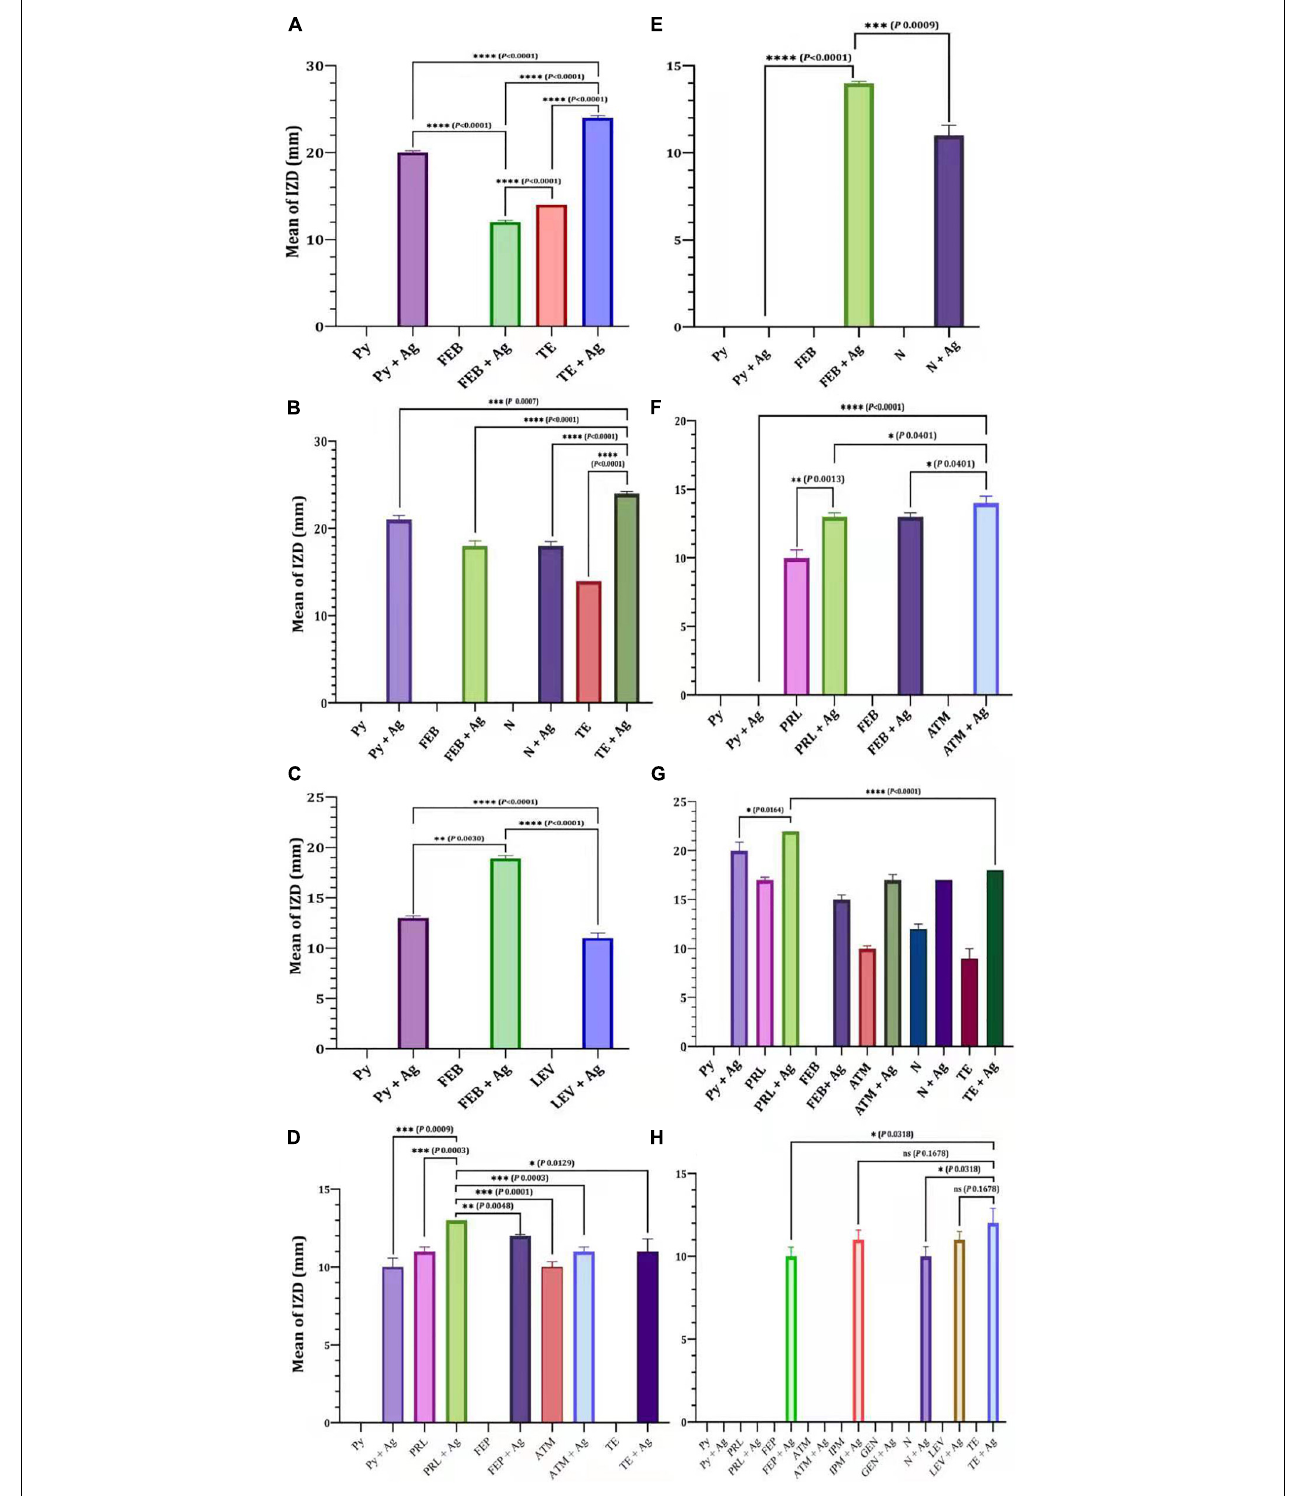
FIGURE 4 | Efficacy of antibiotics alone or in combination with Ag-NPs against selected MDR P. aeruginosa isolates. P. aeruginosa P 1 (A) , P. aeruginosa P 8 (B) , P. aeruginosa P 12 (C) , P. aeruginosa P 18 (D) , P. aeruginosa P 2 (E) , P. aeruginosa P 10 (F) , P. aeruginosa P 14 (G) , P. aeruginosa P 16 (H) . IPM, imipenem; GEN, gentamicin; LEV, levofloxacin; PRL, piperacillin; N, neomycin; TE, tetracycline; ATM, aztreonam; FEP, cefepime; Py, carbenicillin; ns, non-significant. P -value ≤ 0.05 is